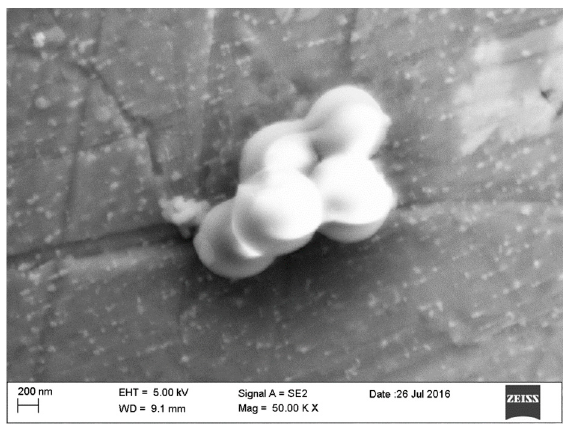
Figure 2. SEM image of corrole-polyacrolein. The diameter of each microsphere is of the order of few hundreds of